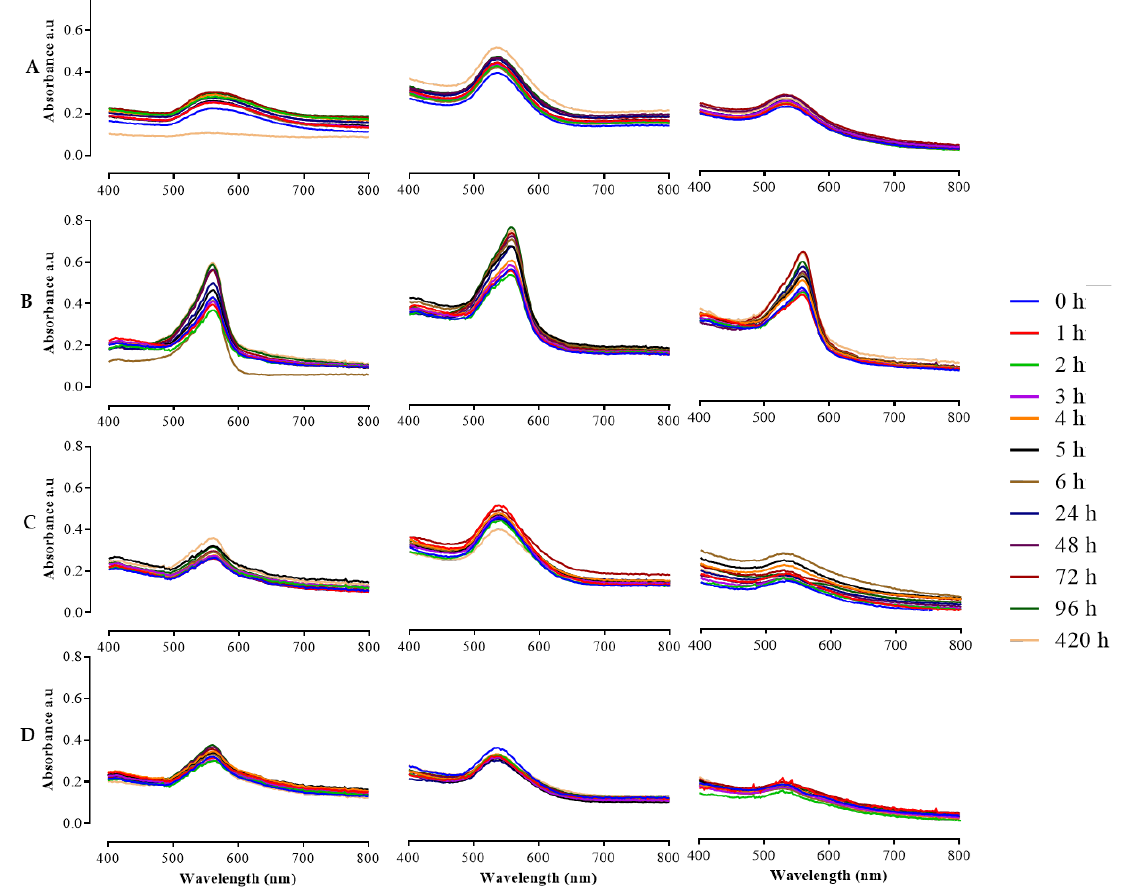
Figure 5. In vitro stability testing of HB-AuNPs. The AuNPs were incubated for 0 to 420 h in water ( A ), DMEM ( B ), RPMI-1640 ( C ), and PBS ( D ); and their stability was measured through UV–Vis